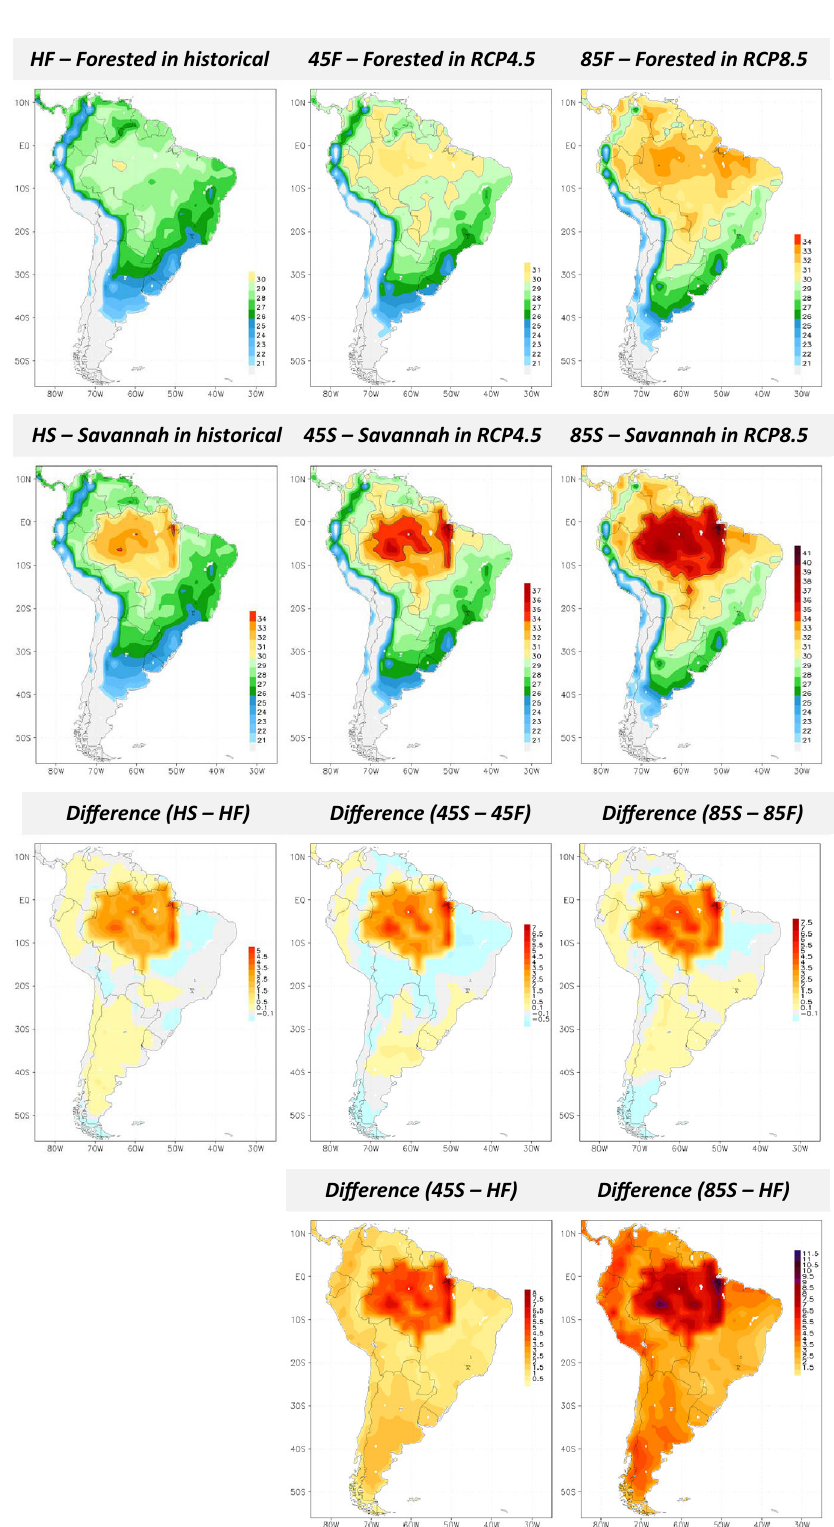
Fig. 1 Average daily maxima of the in-shade WBGT (in °C) for the warmest months. Average daily maxima of the in-shade WBGT (in °C) for the warmest months according to global climate change scenarios for the historical (1980 – 2010) and RCP4.5 and RCP8.5 (2073 – 2100) periods, and land-use scenarios. Global warming scenarios (Historical – H, RCP4.5 – 45, RCP8.5 – 85) and land-use scenarios (Forested – F and Savannah –